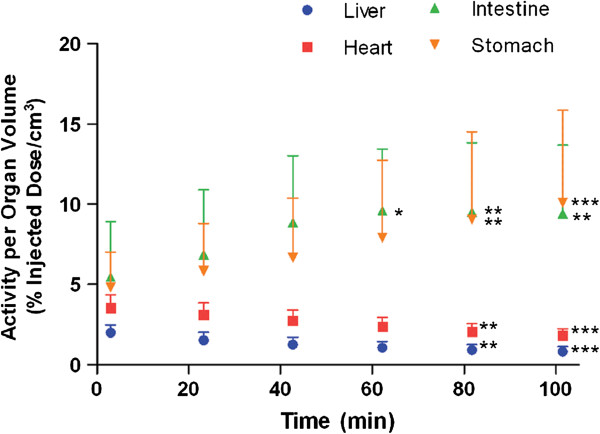
Representative time-activity density curves. The percentage of injected dose by organ volume (%ID/cm3) from heart, liver, intestine, and stomach, expressed as mean ± SD (n = 6), were plotted against time (3 to 102 min) to demonstrate the activity density. * P < 0.05, ** P < 0.001, *** P < 0.0001 versus the data points at 3 min.